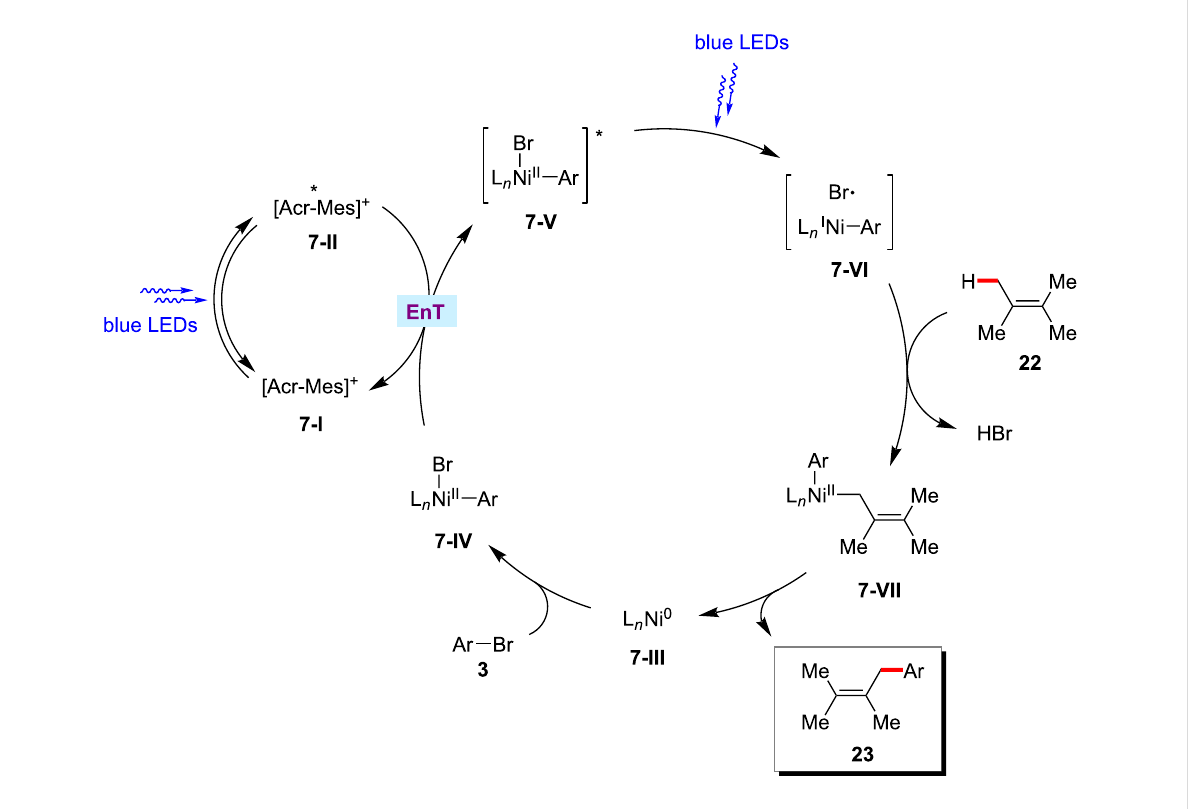
Figure 7: Proposed mechanism for the photochemical nickel-catalyzed allylic C(sp 3 ) ‒ H arylation with aryl